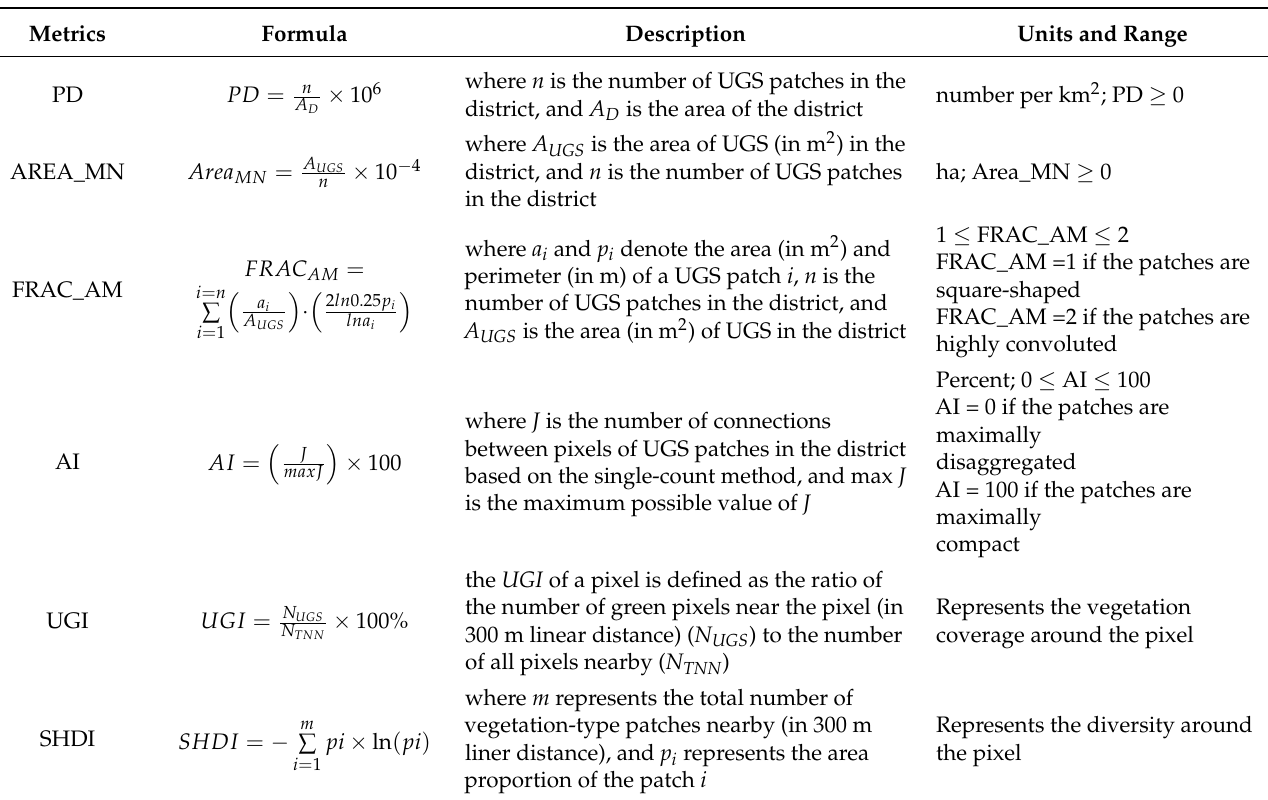
Table 1. Description of urban green space landscape metrics used in the study. Metrics Formula